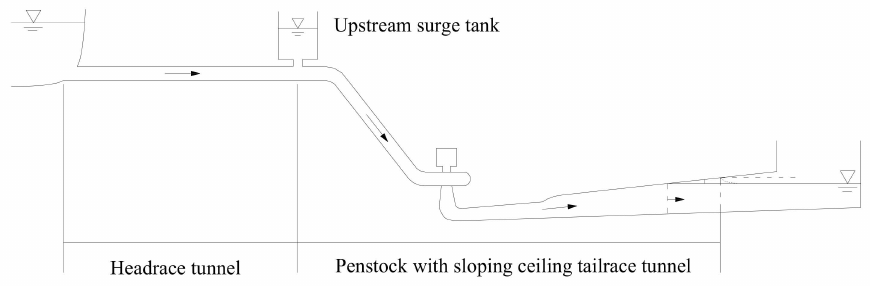
Figure 31. Layout of a hydropower plant with an upstream surge tank and an SCTT. Reproduced with permission from [50], Springer Nature,